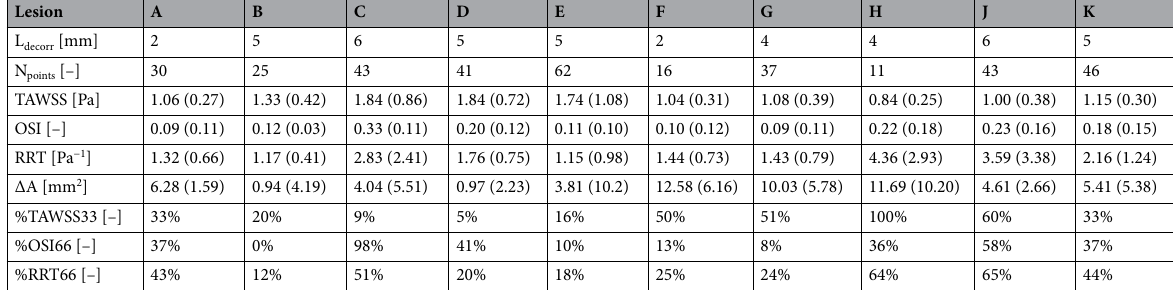
Table 2. Results of the spatial correlation analysis in terms of decorrelation length (L decorr ) and the number of decorrelated data points that are considered for the subsequent statistical analysis (N points ). Median values (interquartile range, IQR) of time-averaged wall shear stress (TAWSS), oscillatory shear index (OSI), relative residence time (RRT), and lumen area change (ΔA), and percentage surface areas exposed to TAWSS33, OSI66 and RRT66 for each lesion under